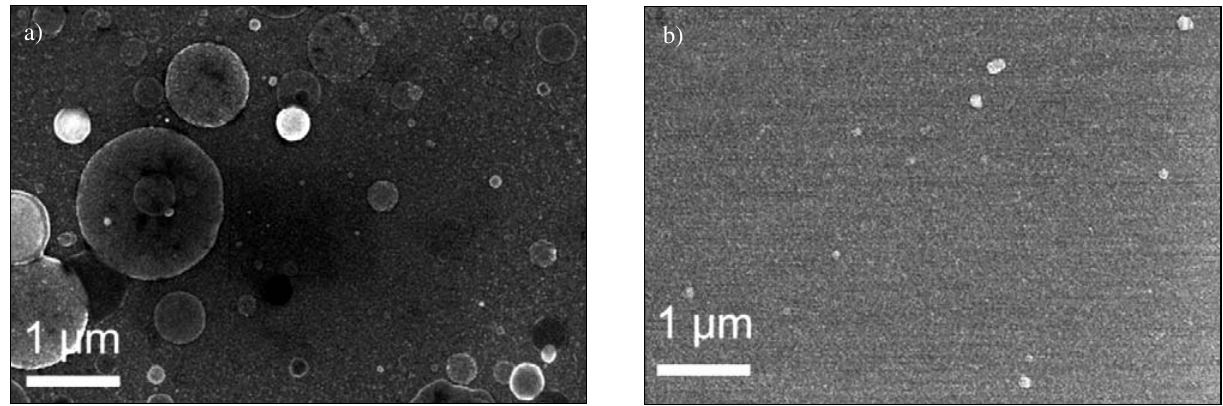
Figure 2. the surface morphology (by FE-SEM) of LiF-Ti nanocomposite thin films, prepared by (a) PLD and (b) co-sputtering